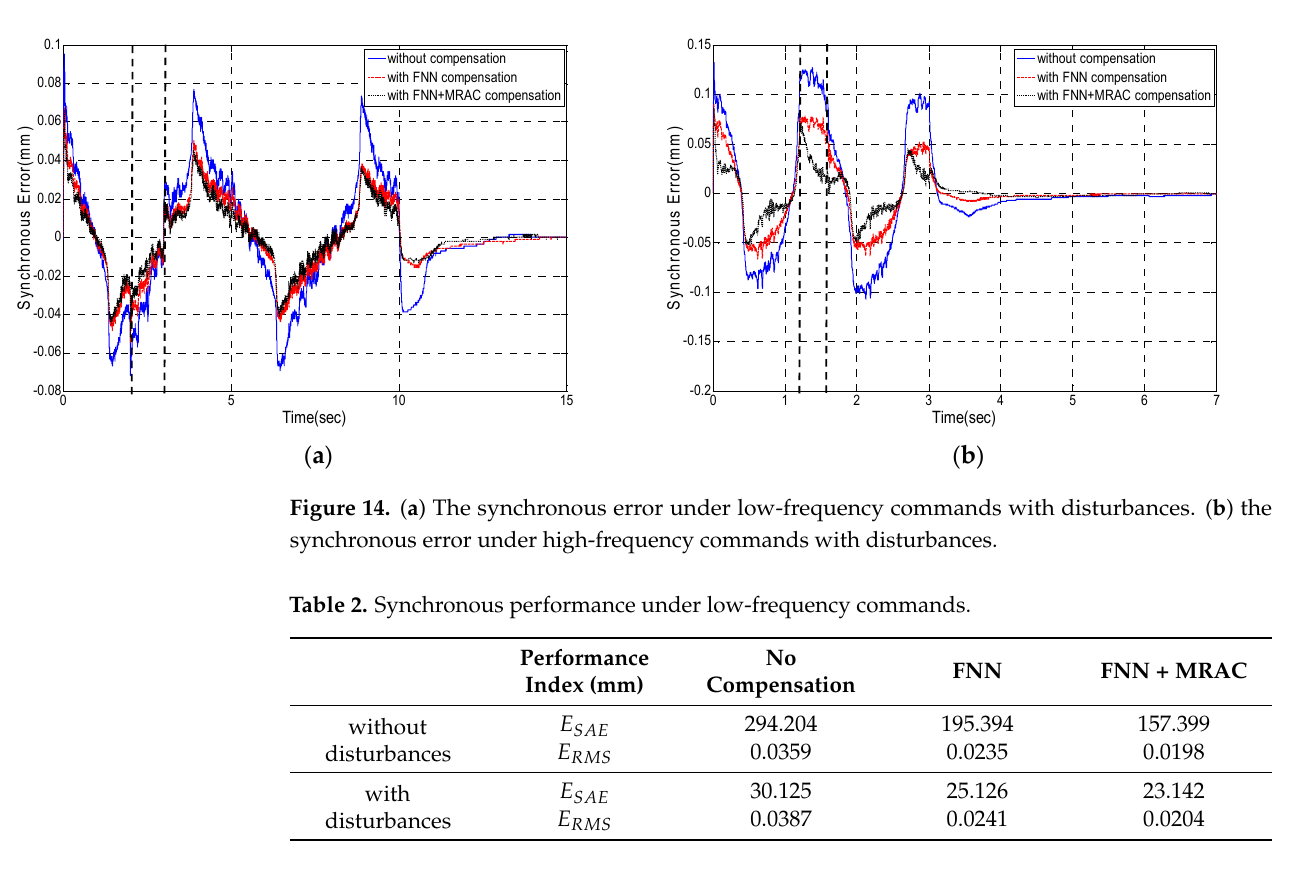
Figure 13. ( a ) The synchronous error under high-frequency commands; ( b ) the cost function under high-frequency commands.